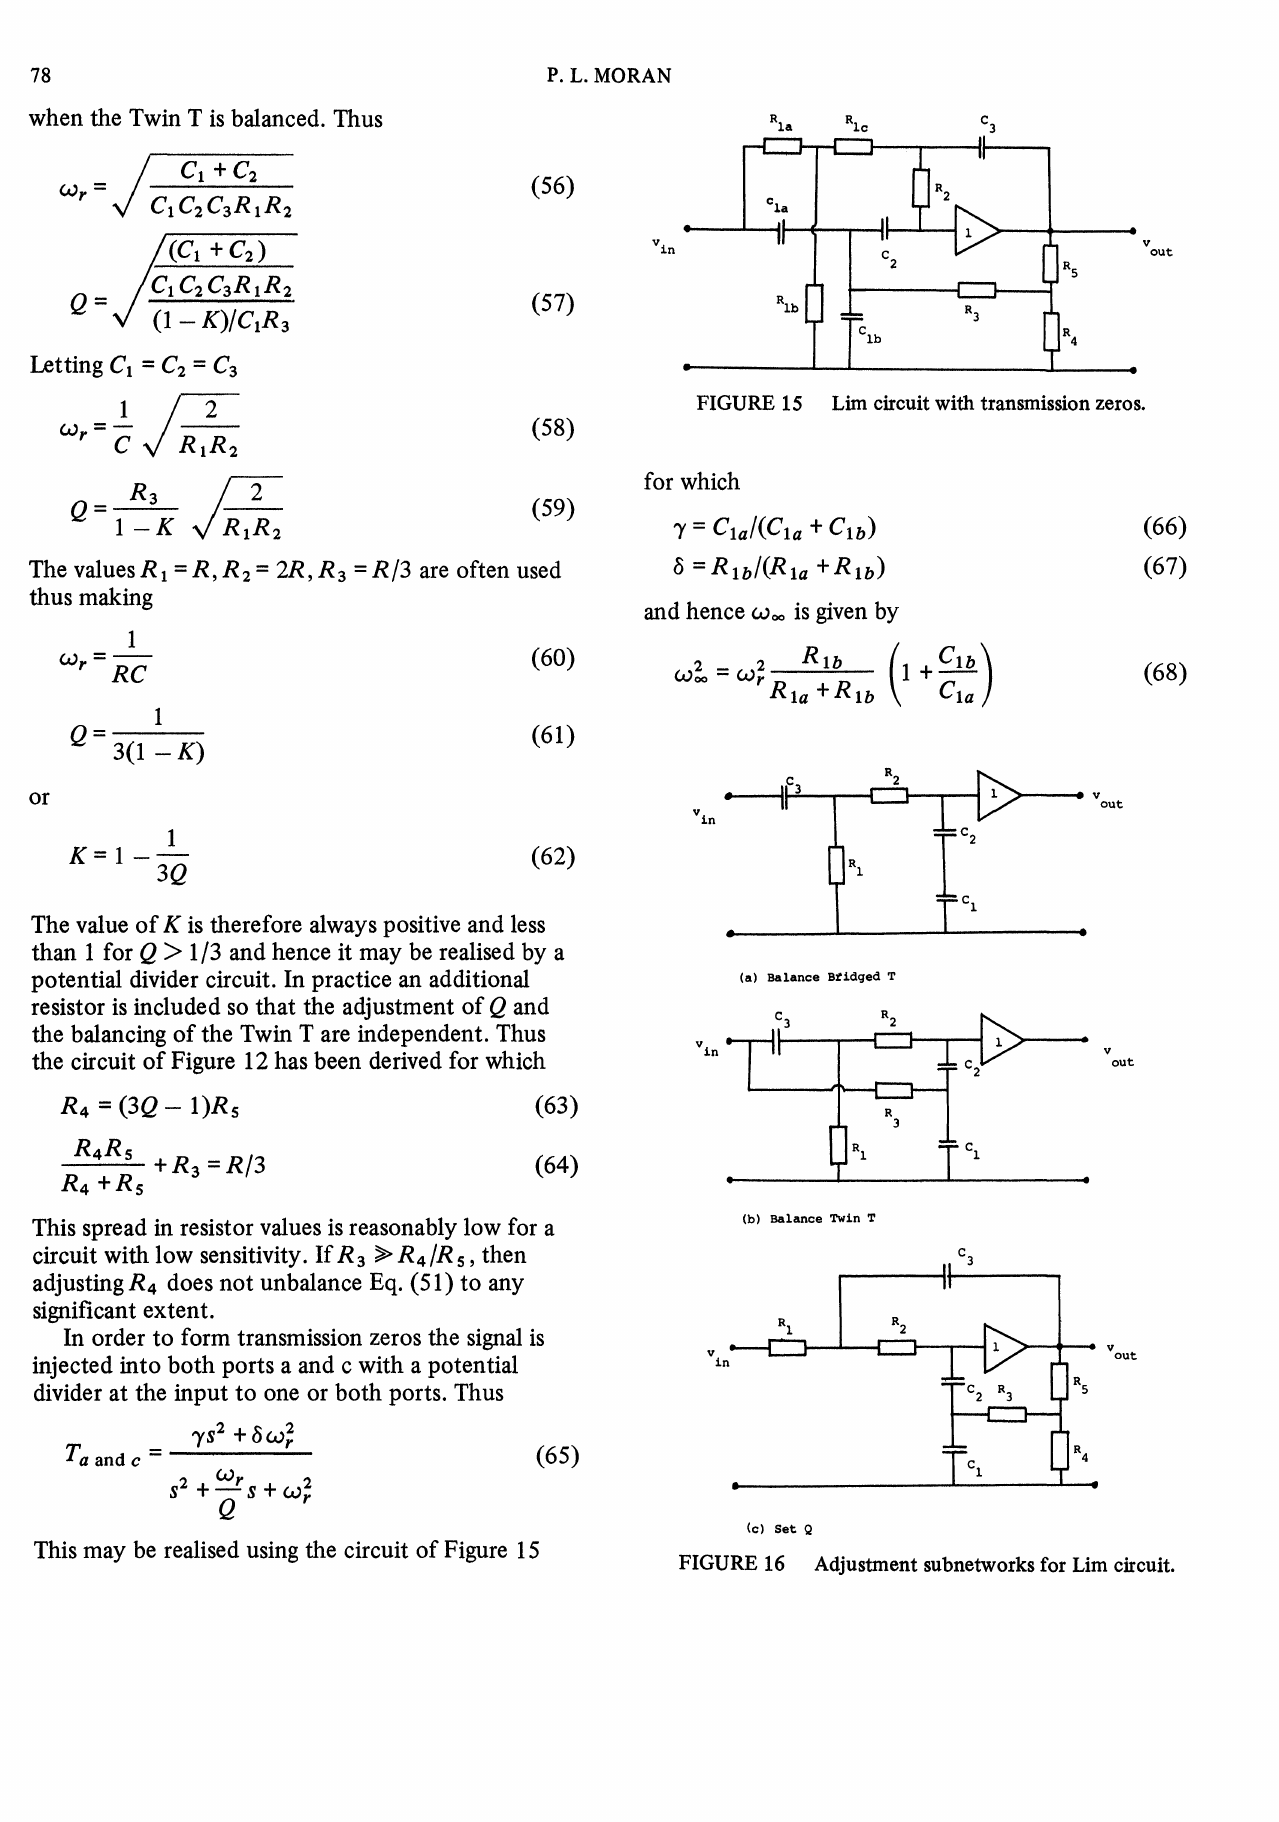
Lim circuit with transmission zeros.